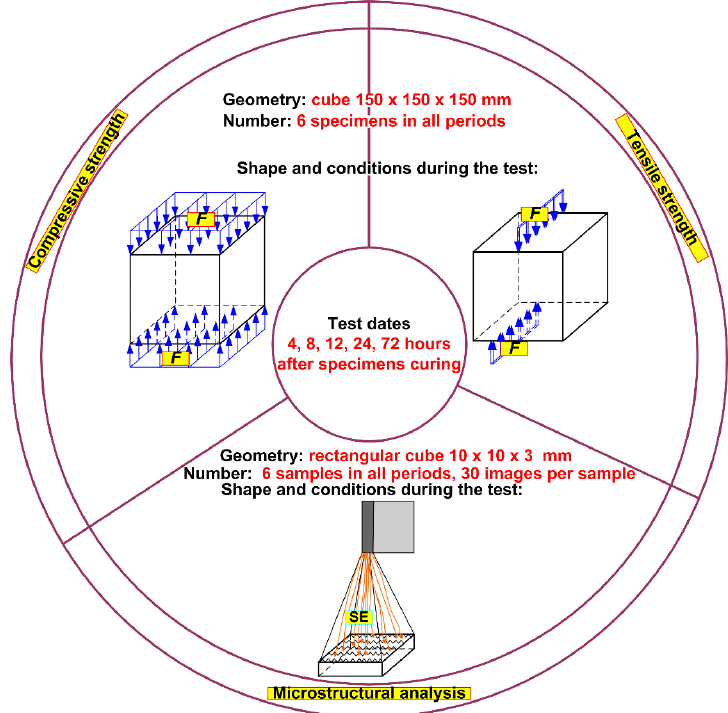
Figure 2. Flowchart of the study: F—force, SE—secondary electrons.